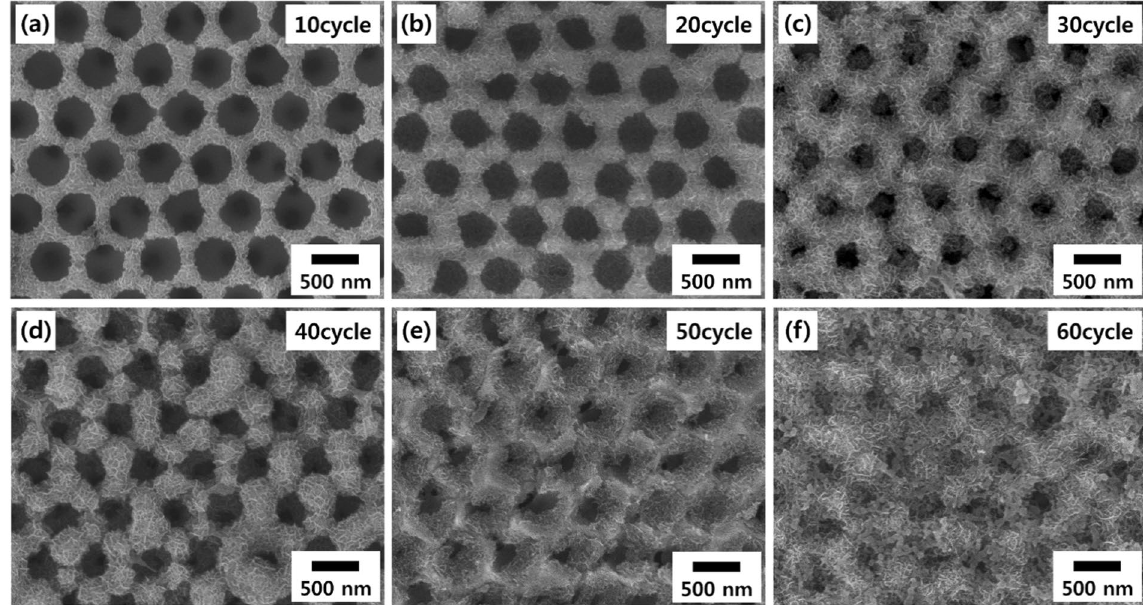
Figure 3. Surface morphology of the nanostructured MnO 2 electrodes. Surface FE-SEM images of MnO 2 thin films electrodeposited on a 5Lyr inverse-opal Ni nanostructure. The number of electrodeposition cycles is ( a )